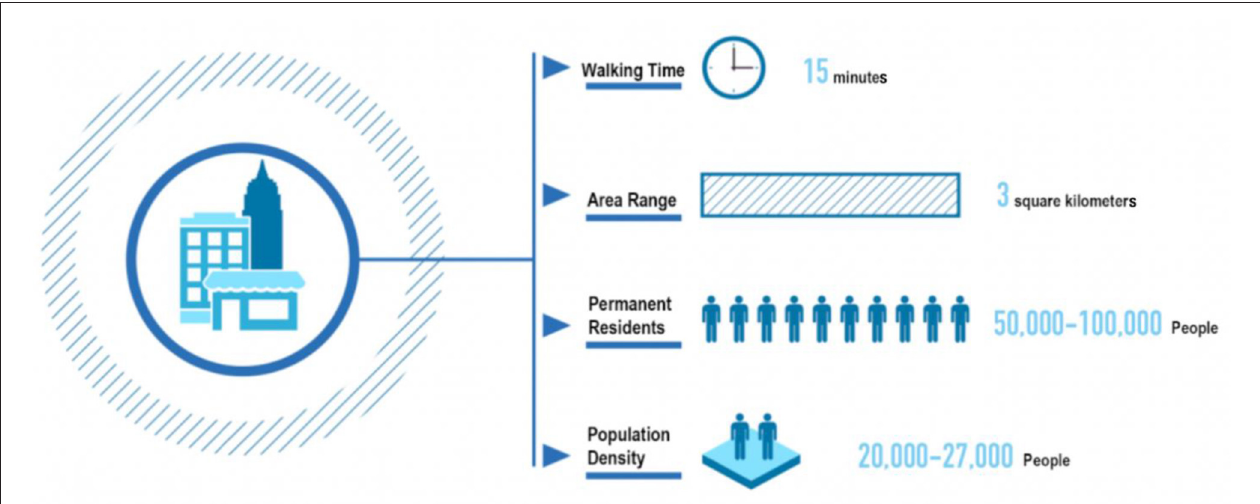
FIGURE 8 | Basic mode of 15-min community life circle (Source: Authors).